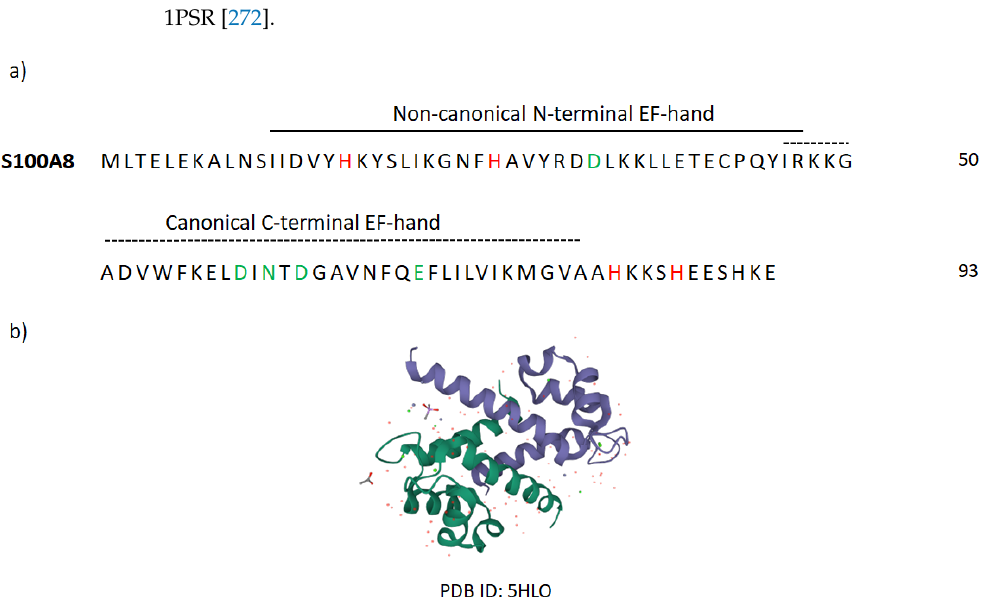
Figure A3. Structures of S100A8 protein: ( a ) predicted amino acid sequence of the human S100A8 (the red color marks those amino acids that bind Zn 2+ , while the green color marks the amino acids that bind Ca 2+ ); ( b ) structure of calcium and zinc-bound human S100A8 in space group C2221—image from the RCSB PDB (rcsb.org) of PDB ID 5HLO [273].